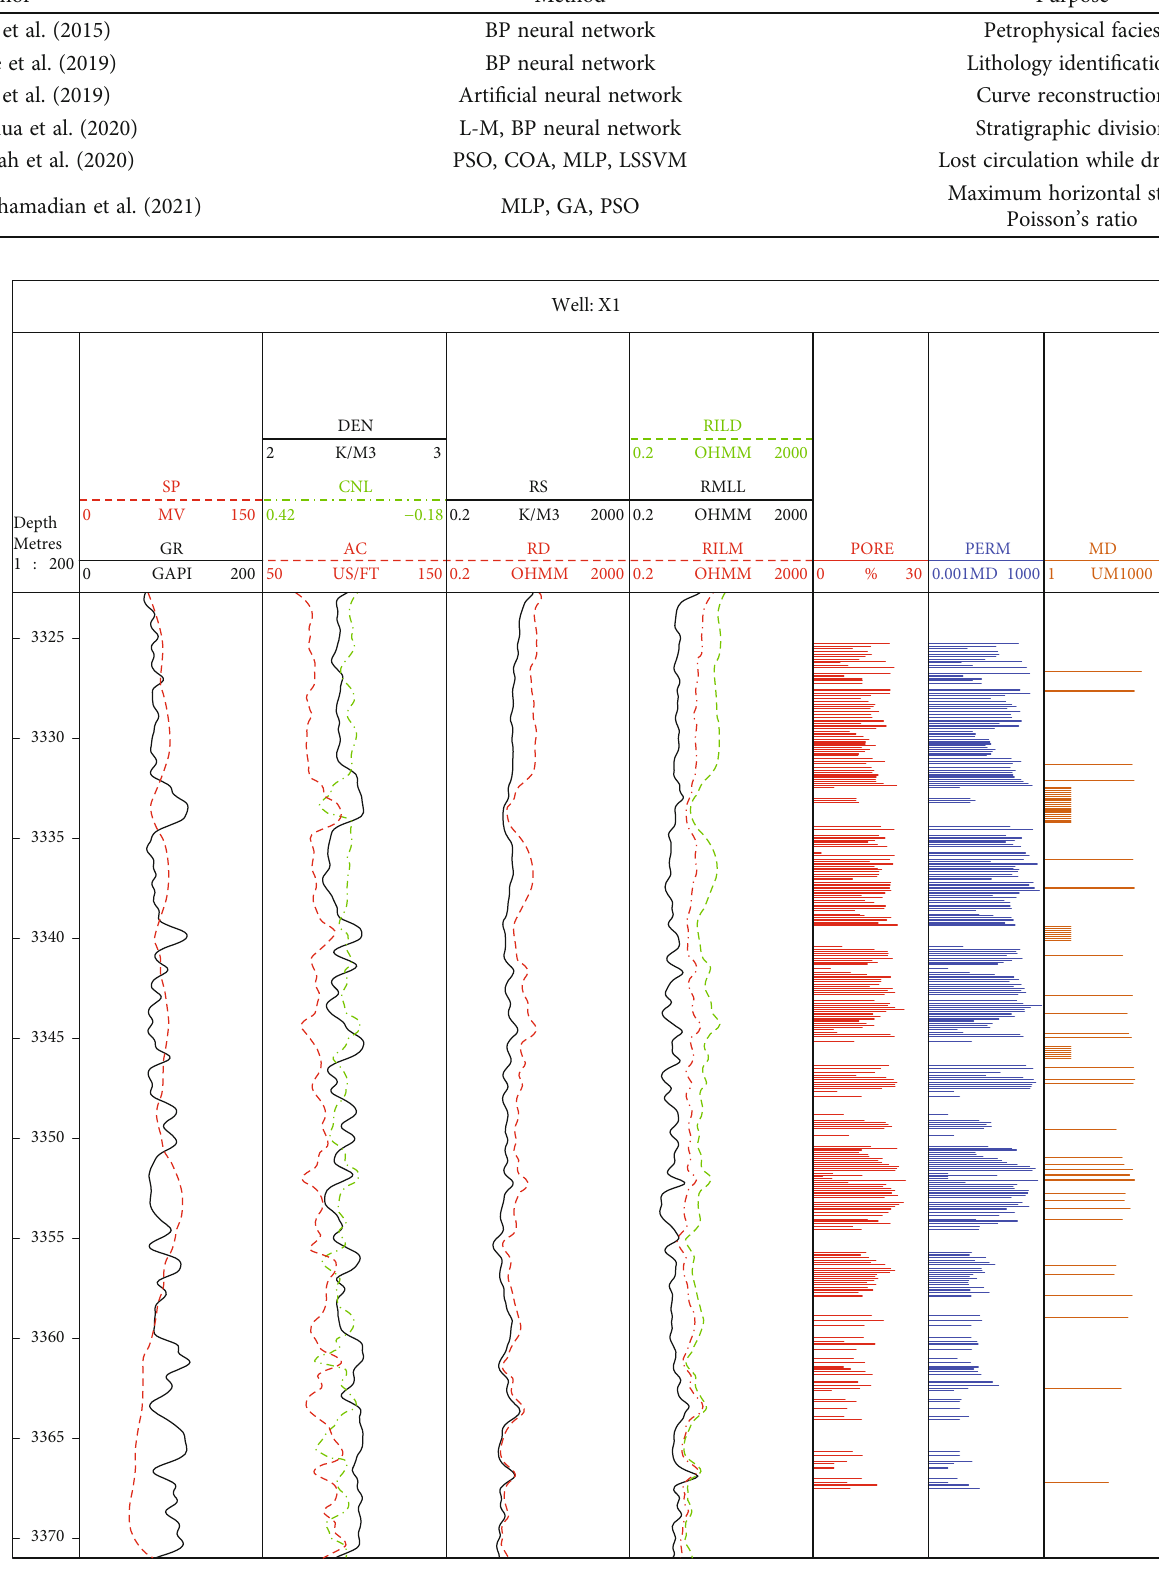
Figure 1: Conventional logging curve and core experiment analysis diagram of S